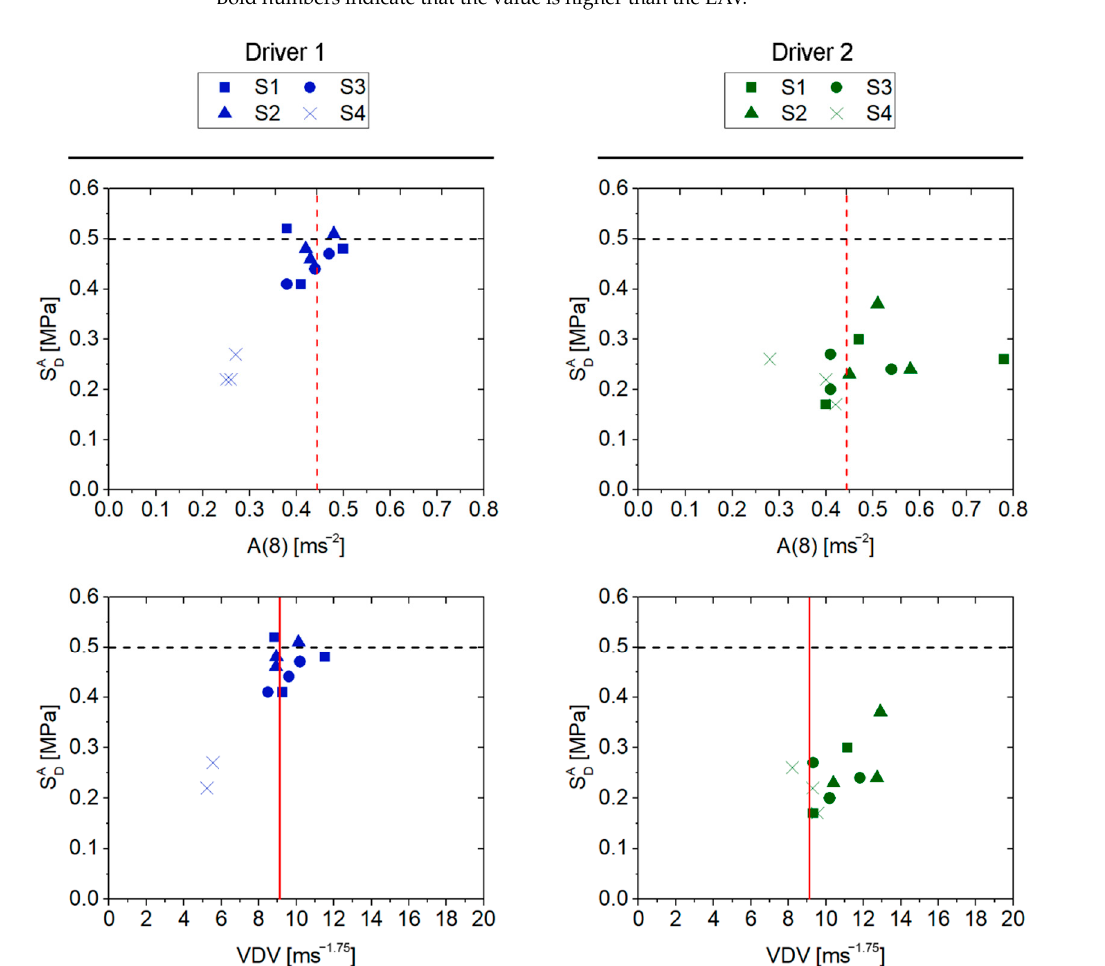
Figure 5. Comparison between results of different WBV assessment methods. Dashed black line indicates low risk probability limit. Dashed red line indicates EAV limit for A(8) method. Solid red line indicates EAV limit for VDV method.